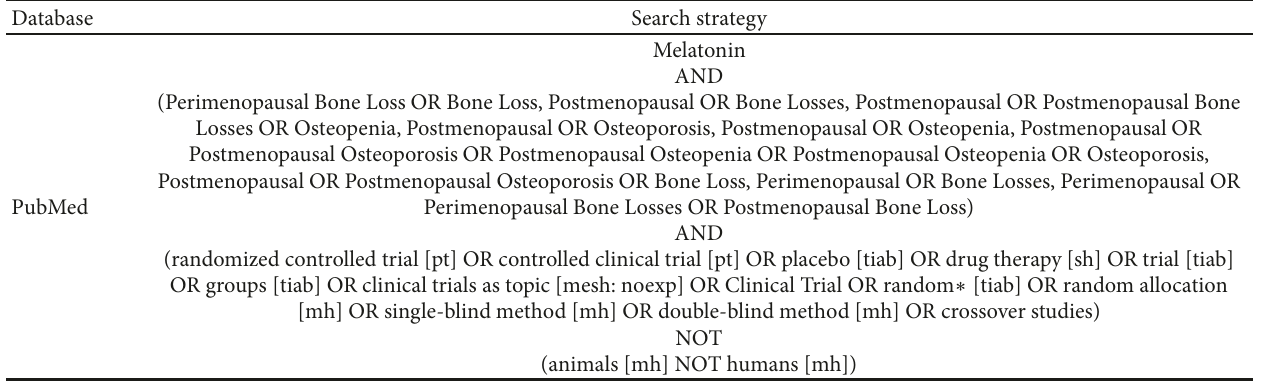
Table 1: Search strategy for